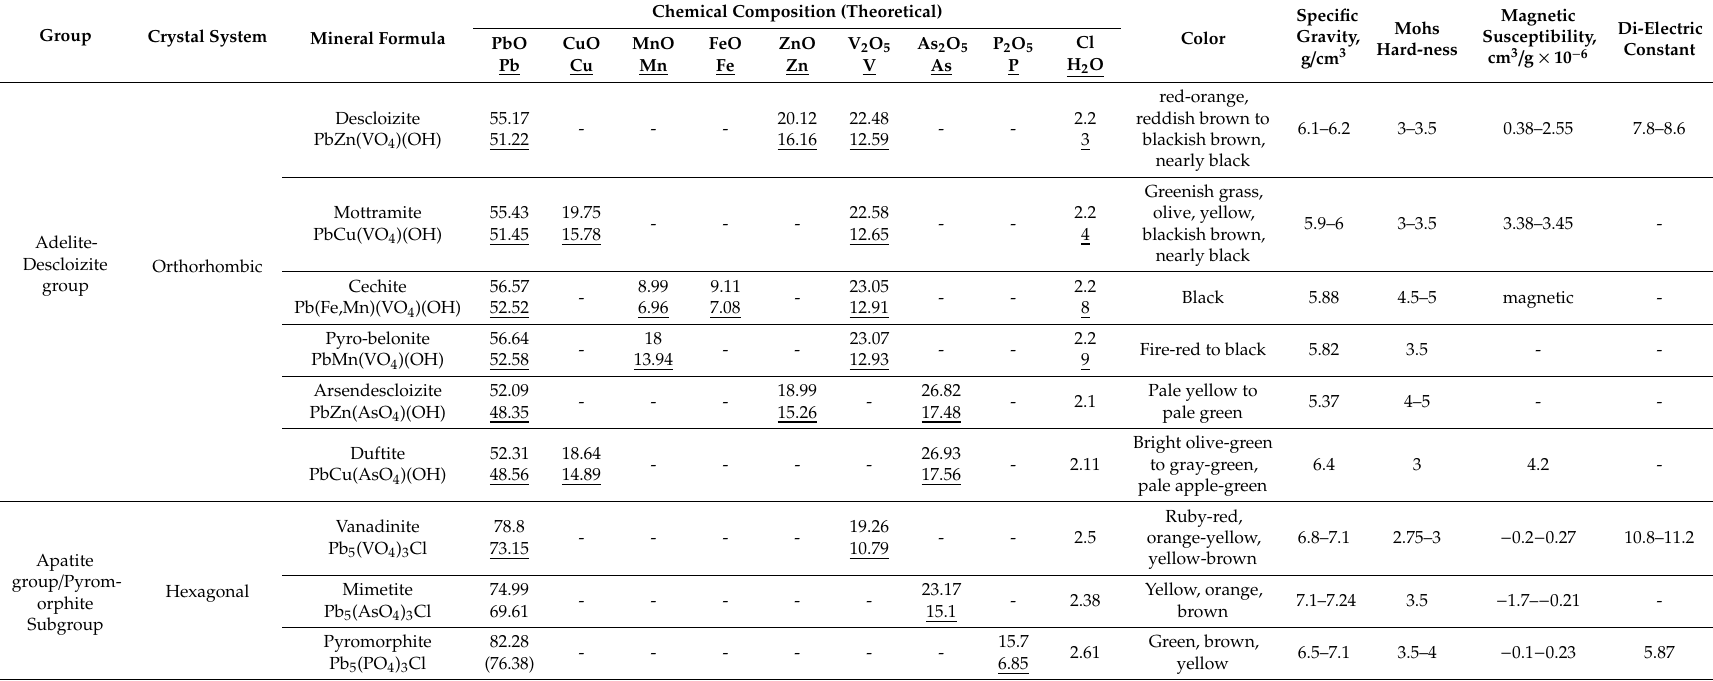
Table 3. The main properties of lead vanadate minerals and commonly associated minerals